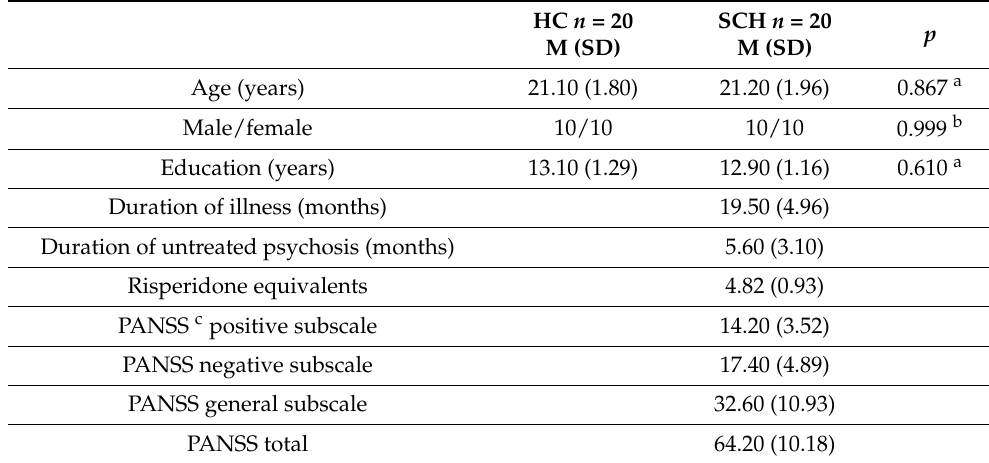
Table 1. Demographic and clinical characteristics of the studied